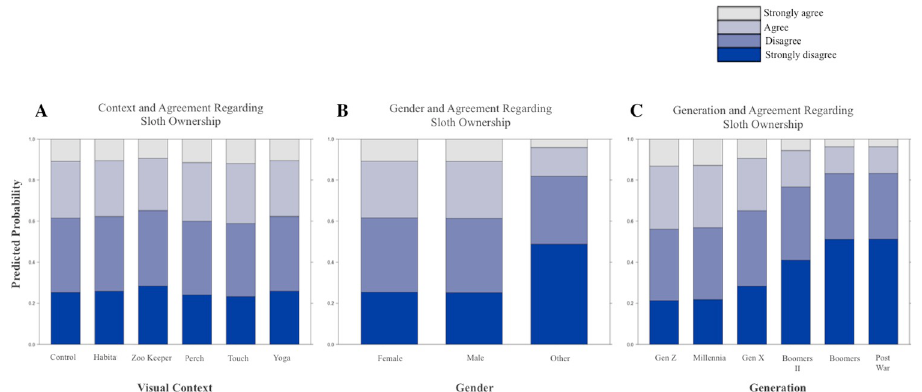
Fig 2. A-C. Predictor Effect Plots Showing the Role of Each Predictor on Interest in Sloth Ownership. Predictor effect plots provide graphical summaries for fitted regression models by averaging and conditioning the other predictor variables to summarize the role of a selected focal predictor in a fitted regression model (Fox & Weisberg, 2019). (Note: Figures sized to span two columns).